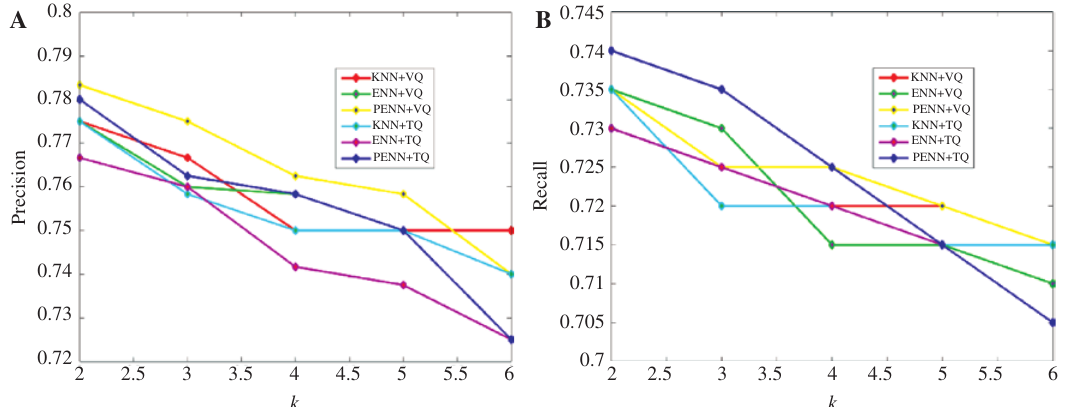
Figure 12: (A) Precision Graph. (B) Recall